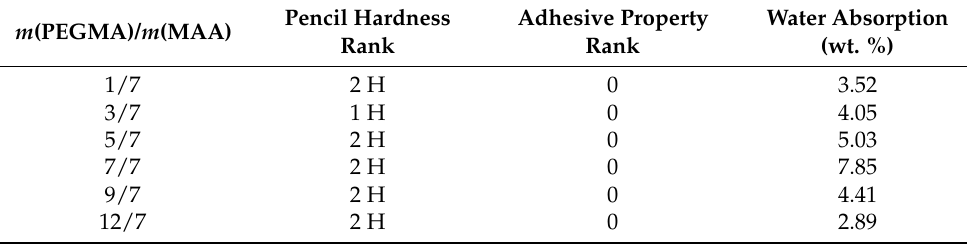
Table 9. Properties of the cured film with different amounts of PEGMA.